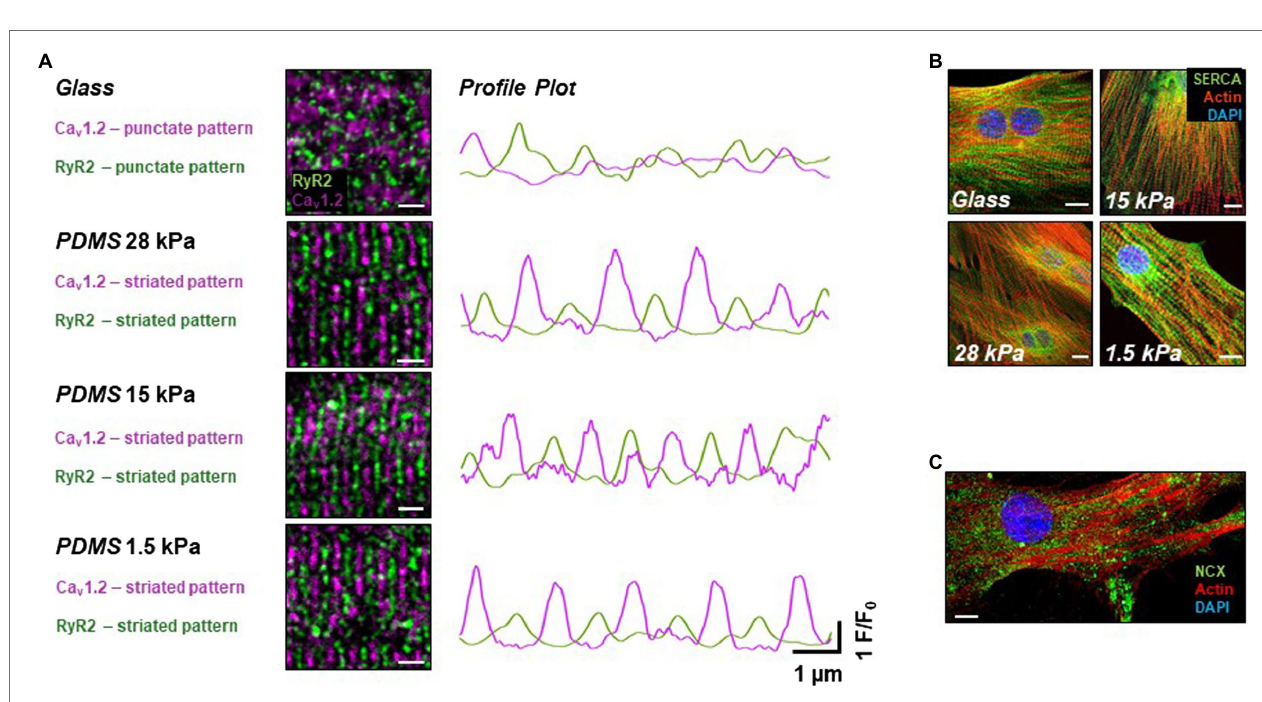
FIGURE 3 | Expression pattern of Ca 2+ handling proteins in iPSC-CMs grown on different soft surfaces. (A) Immunostainings of L-type Ca 2+ channel Ca v 1.2 (purple) and RyR2 [green, scale bar (SB) = 2 μ m] and intensity profiles drawn from regions of interest along the vertical axis indicating parallel alignment of both ion channel expression patterns relative to each other by alternating peaks in iPSC-CMs plated on soft surfaces compared to glass. (B) Expression pattern of SERCA (green), actin (red), and nucleus (blue) revealing similar distribution of the SR network in iPSC-CMs grown on all tested surfaces (SB = 10 μ m). (C) Representative image of NCX stainings (green) together with actin (red) and nucleus (blue) showing a dotted distribution all over the sarcolemma (SB = 10 μ